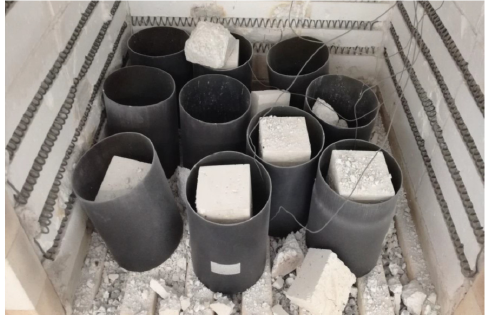
Figure 6. View of samples after temperature loading.